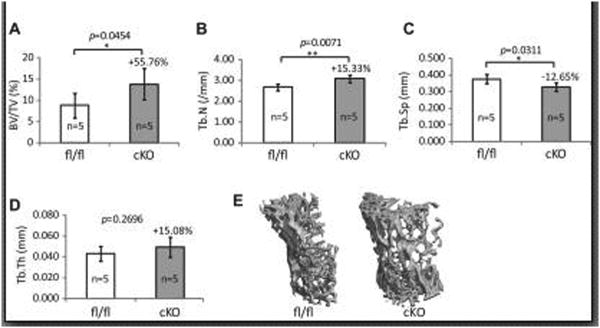
(A-D)
μCT analysis of lumbar spine (L4) showing BV/TV, Tb. N, Tb. Sp and Tb. Th of 6.5-month-old male PPARγ cKO (solid bar) and double-floxed control (empty bar) mice. (E) Representative three-dimensional reconstructed images of L4 lumbar spine. Values are given as mean ± SD.